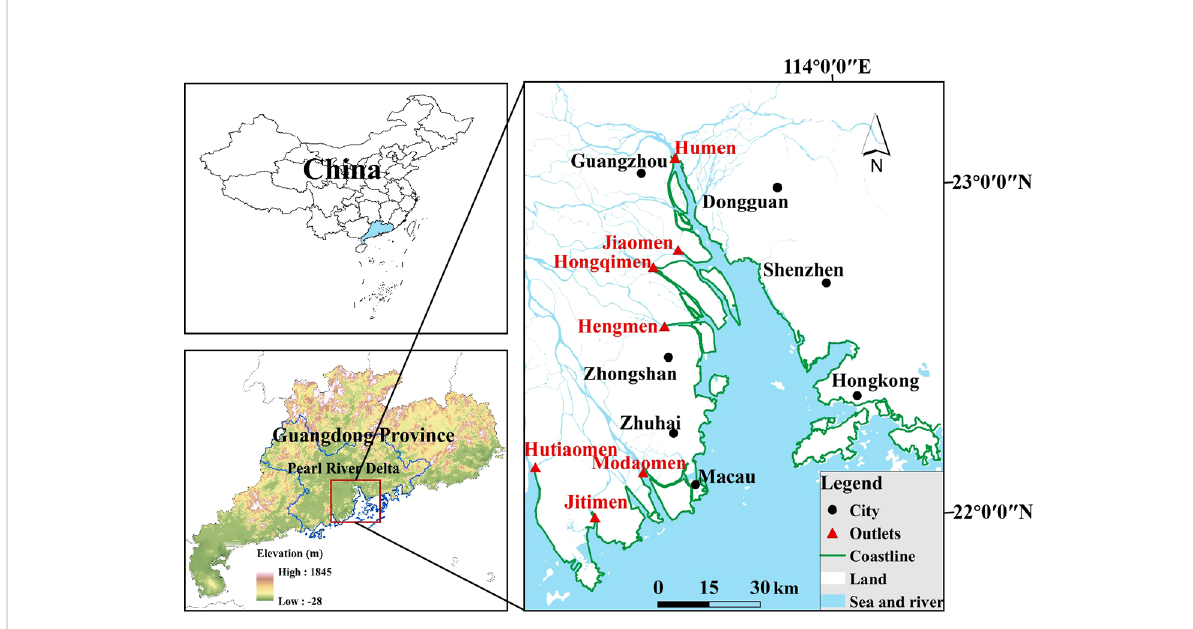
FIGURE 1 Location of the Pearl River